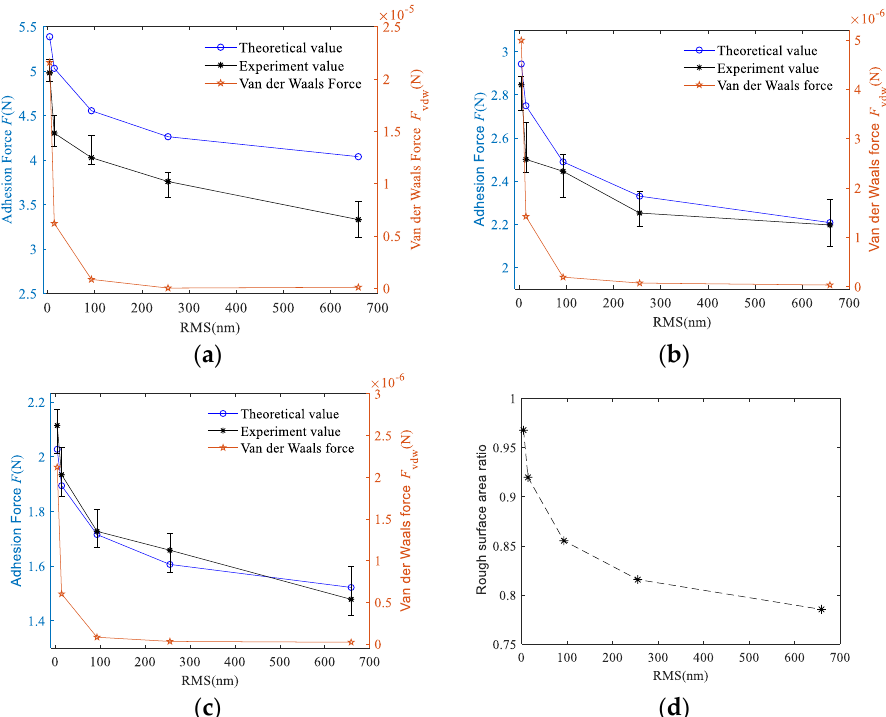
Figure 5. Effect of root mean square roughness (RMS) on adhesion force: ( a ) the droplet volume is 50